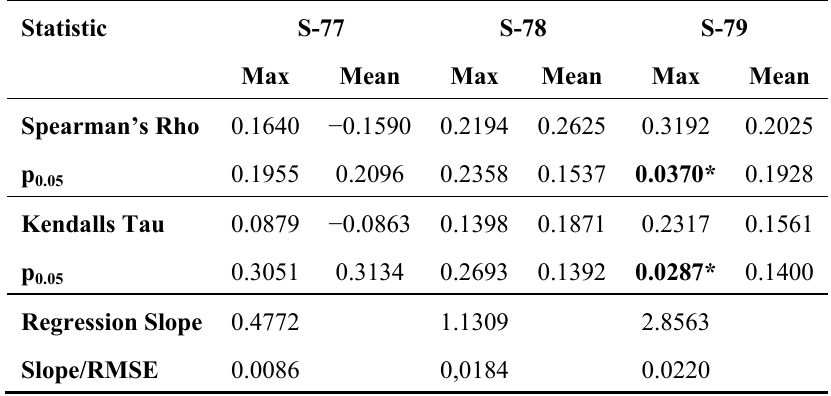
Table 6. Results from trend analyses of annual maximum and mean time series for